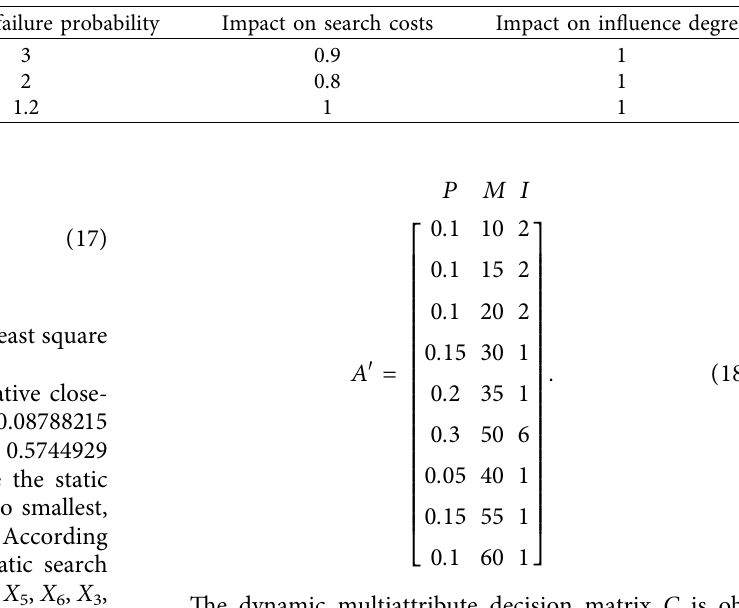
Table 4: Gearbox vibration influence matrix N